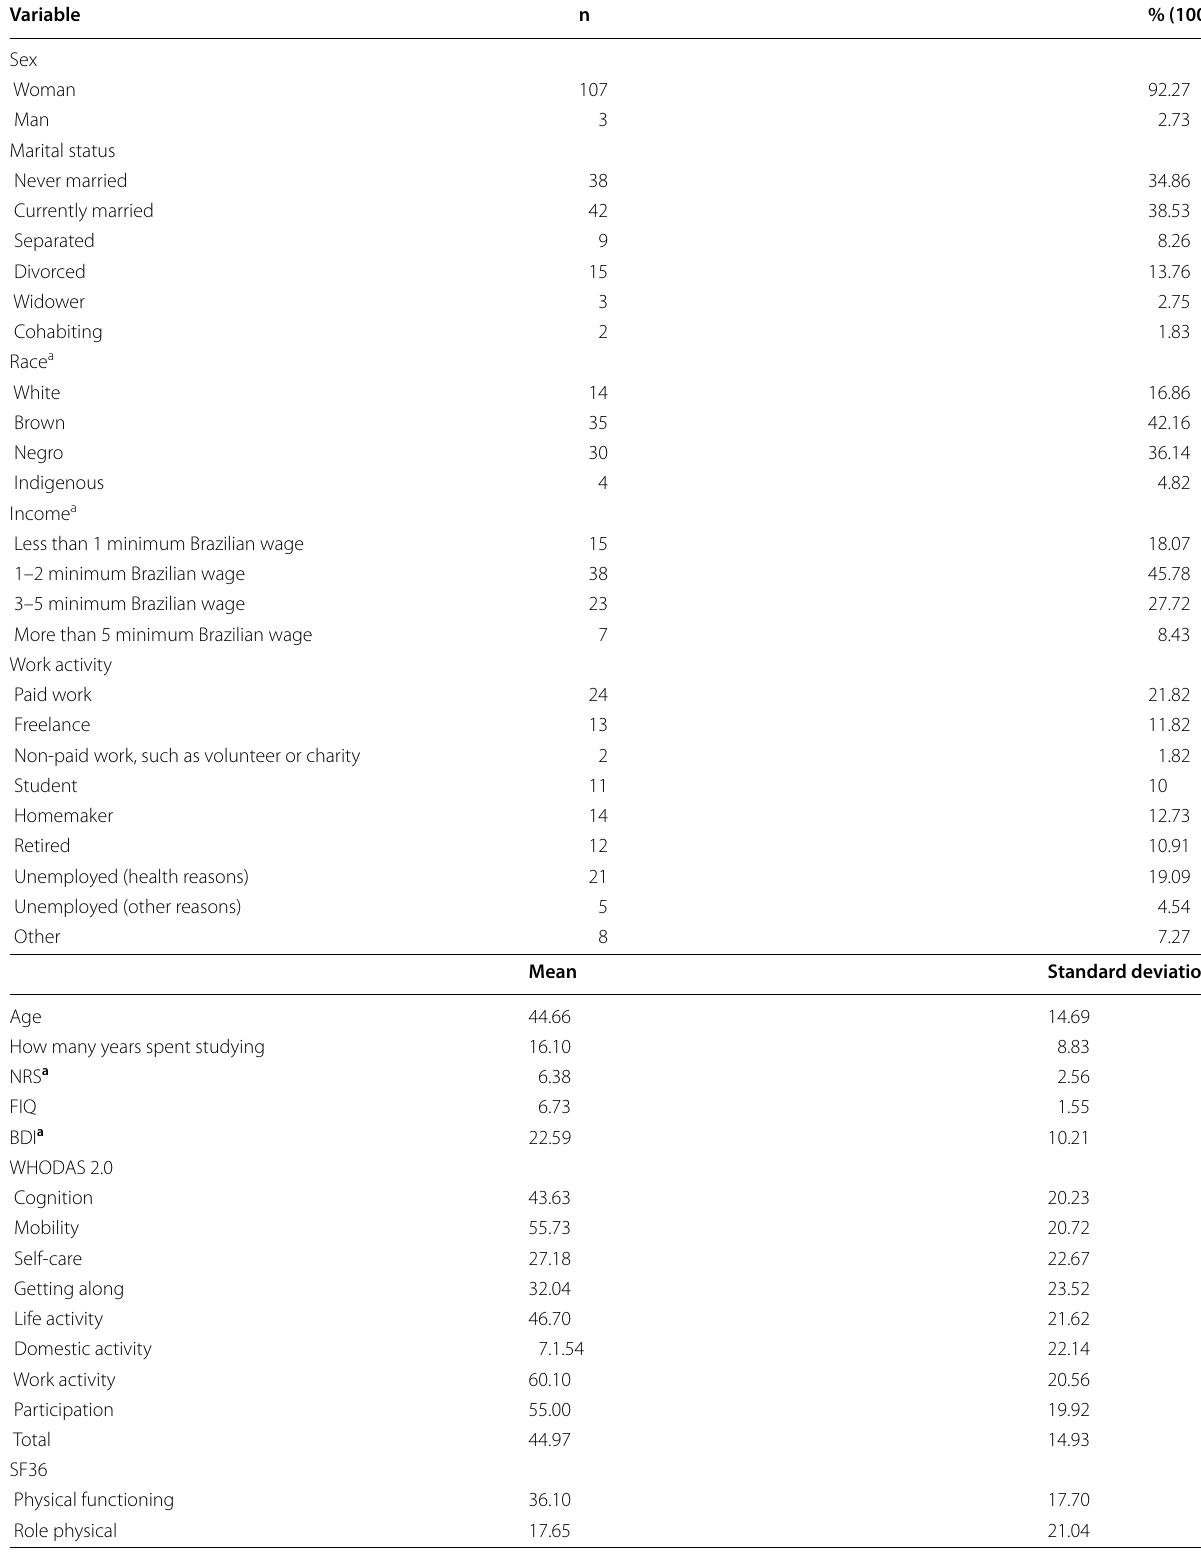
Table 2 Description of the sociodemographic, clinical, and functional